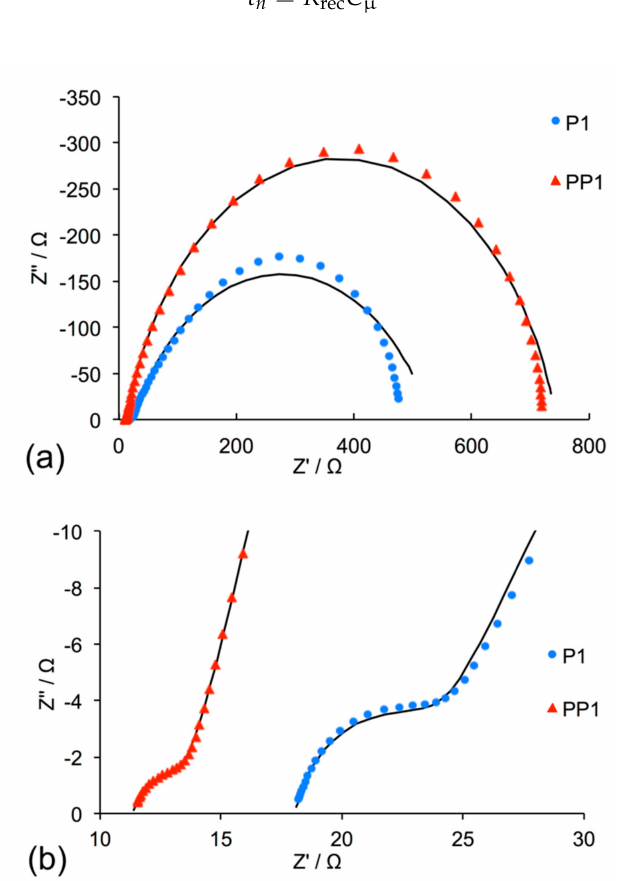
Figure 8. ( a ) Nyquist plots for DSCs containing P1 or PP1 . ( b ) Expansion of the high frequency region of the Nyquist plots. Fitted curves are shown as solid black